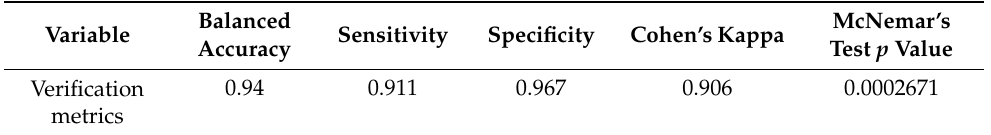
Table 3. Random forest (RF) validation results.